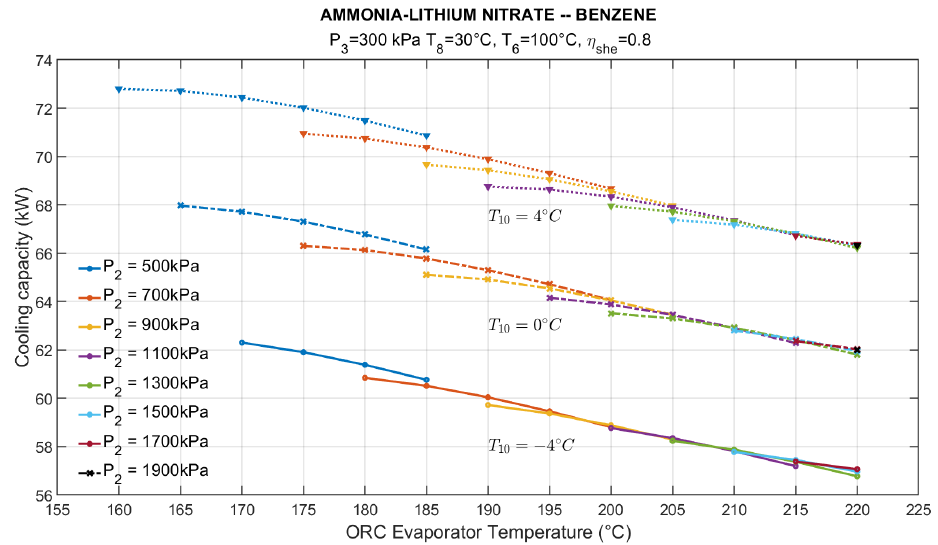
Figure 3. NH 3 -LiNO 3 --C 6 H 6 e ff ect of heat source and cooling temperatures on the cooling load.